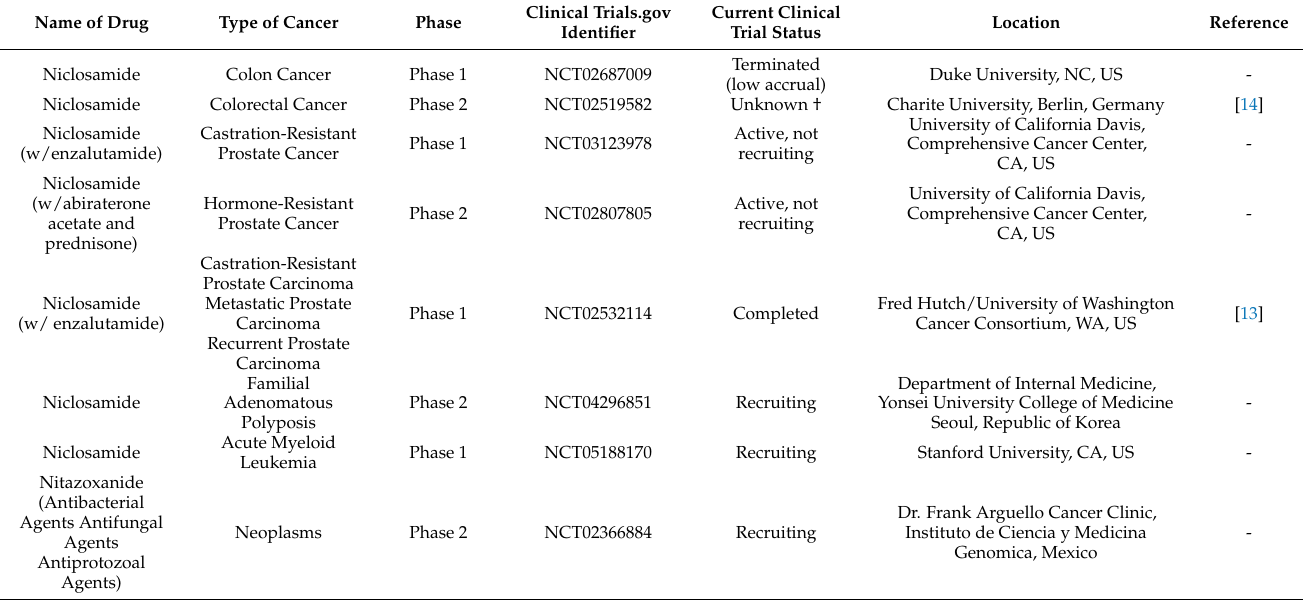
Table 2. List of cancer clinical trials with niclosamide and